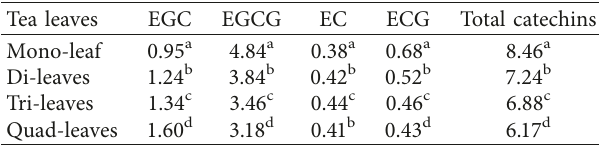
Figure 2: Effect of the plucking standard of fresh tea leaves on the TF concentrations of fermented juices ( n � 3). Table 3: Content of catechins (%) in fresh tea leaves with different plucking standards.